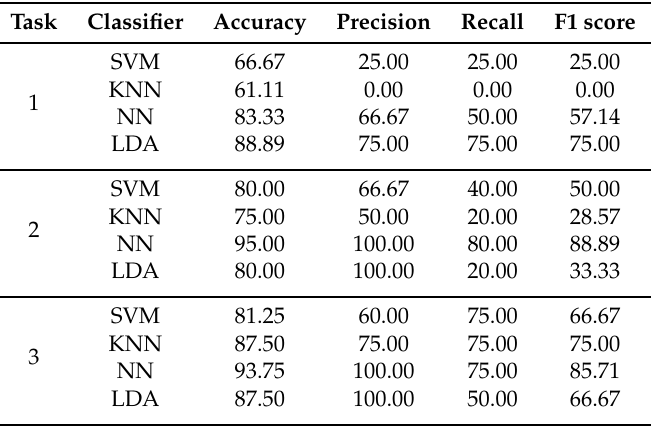
Table 4. Accuracy, precision, recall, and F1 score as percentages when task time, path length of both the instrument and the arthroscope, and maximum bending force of the instrument are used as inputs to the classifiers.